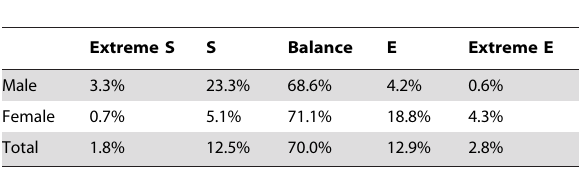
Table 2. The proportion of males and females by the classification scheme shown in Figure 1.